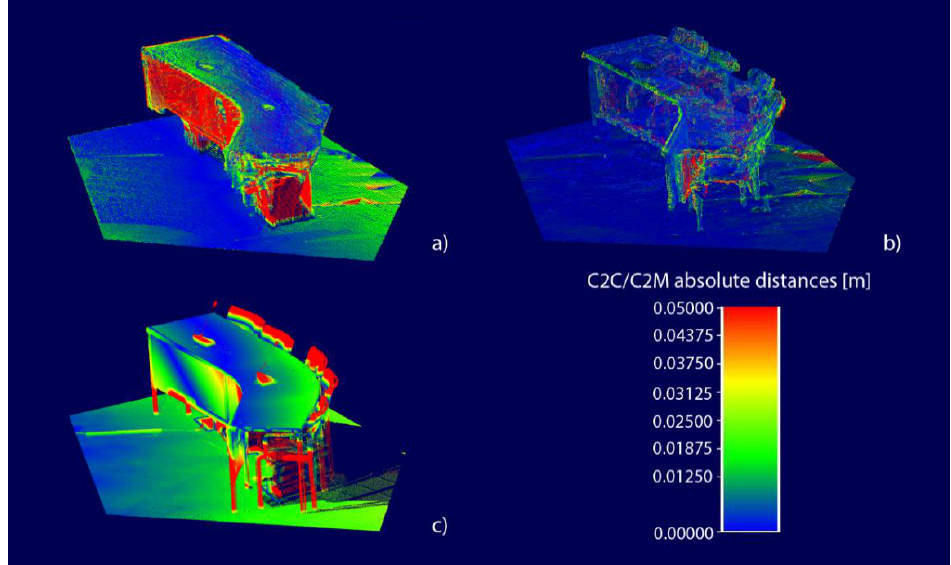
Figure 9. C2C distances of the Theta V point cloud ( a ) and Matterport point cloud ( b ); C2M distances of the Theta V mesh ( c ) in the Tetra segment.